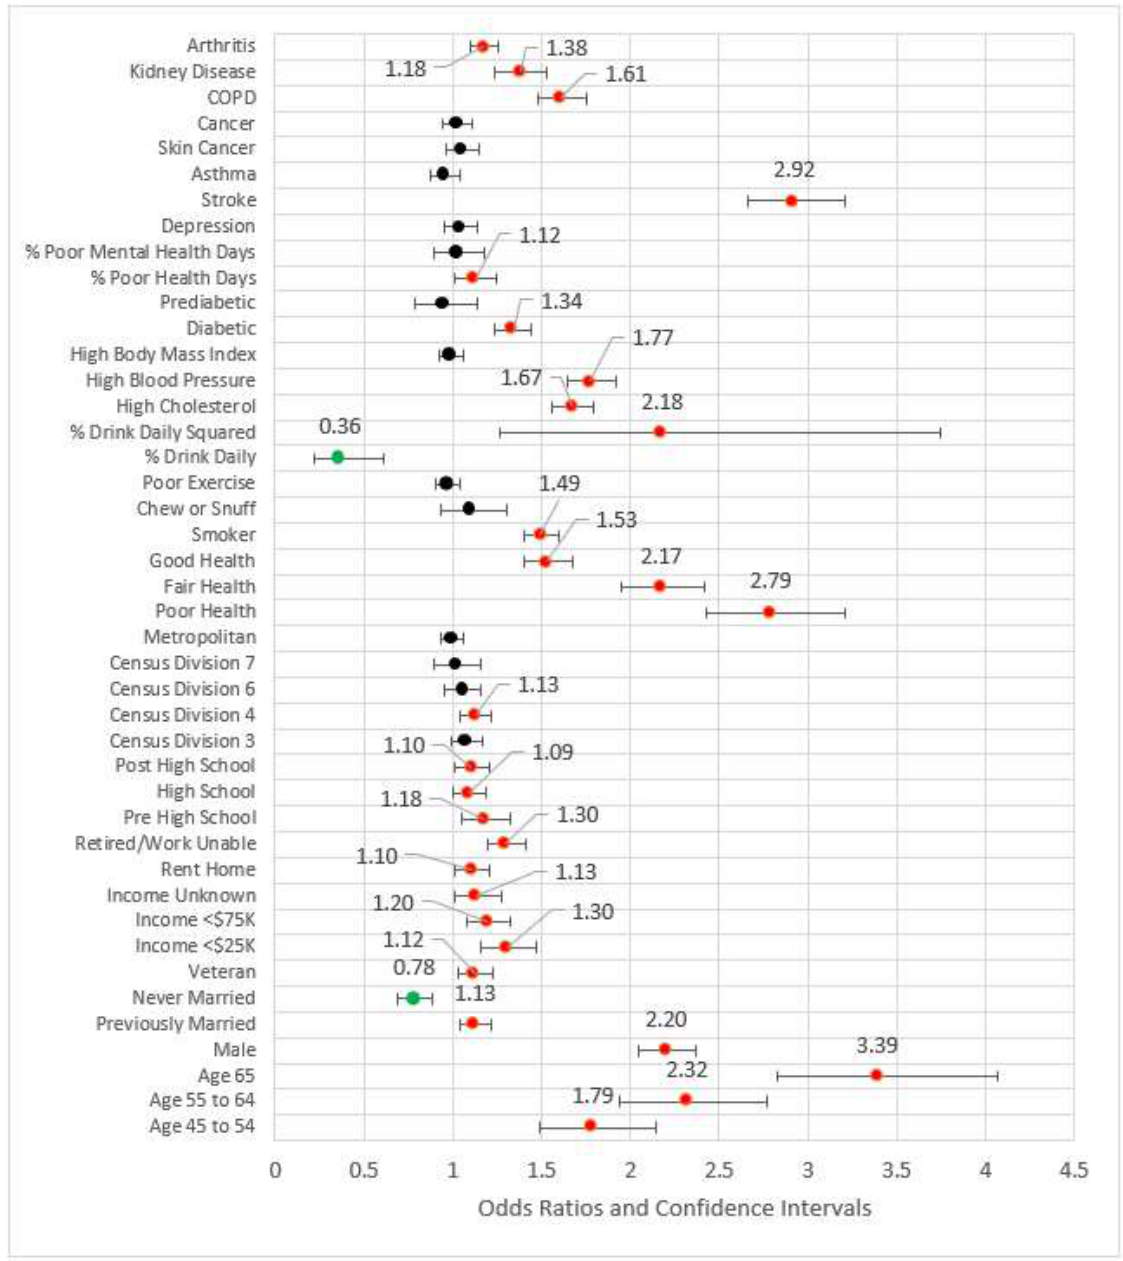
Figure 4. Forest plot of Model 4 (red = significant odds ratios greater than 1.0, green = significant odds ratios less than 1.0, black = not significant) .